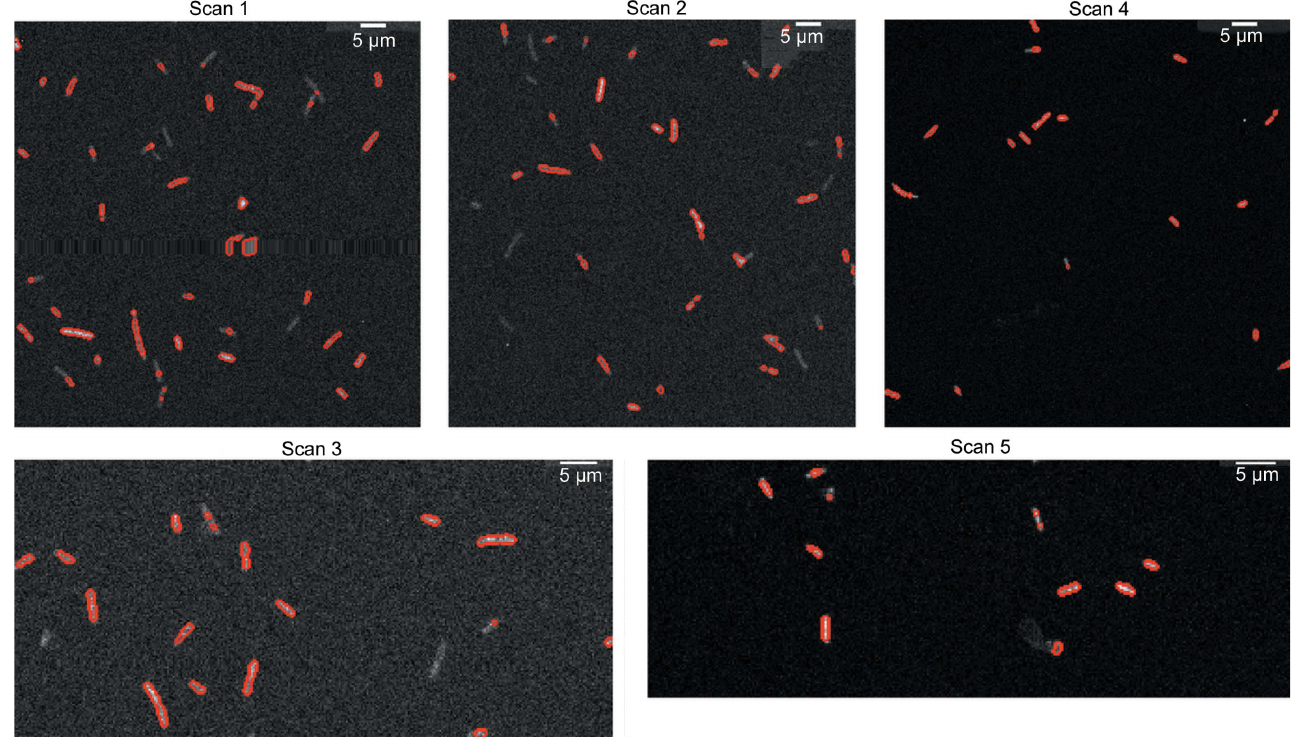
Figure 2 Segmentation masks of the coarse scans containing type A and B cells. Red indicates the boundary between the cell and background regions as detected by the segmentation scheme. Pixels inside the cells are labeled 1 and the background is labeled